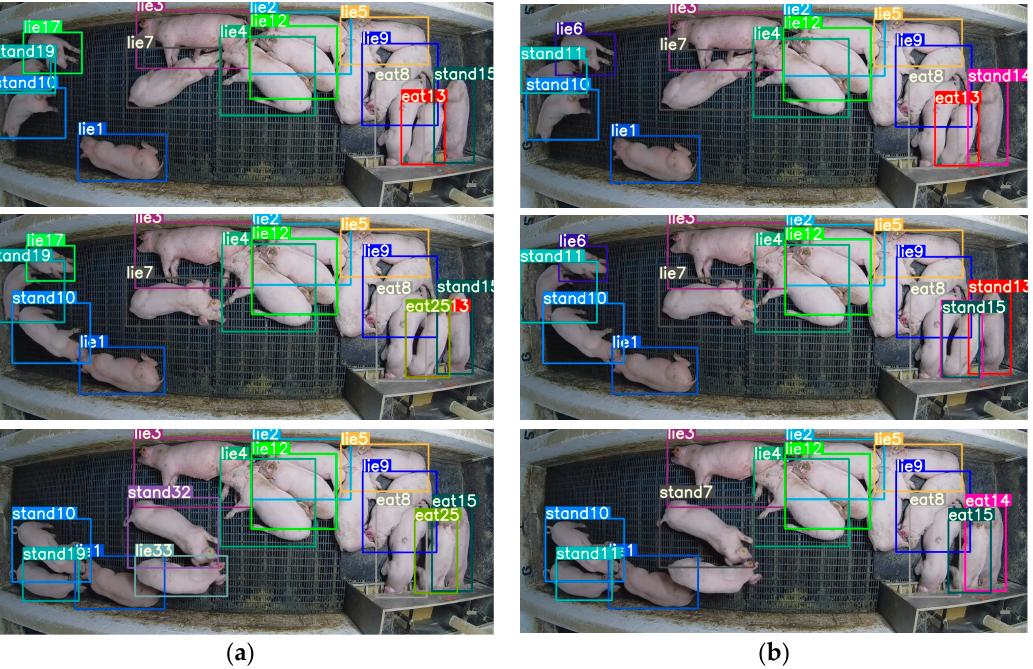
Figure 10. Results comparison between DeepSORT and improved DeepSORT based on YOLO v5s model of Pig03. ( a ) DeepSORT, at frames 50, 100, and 150; and ( b ) Improved DeepSORT, at frames 50, 100, and 150.